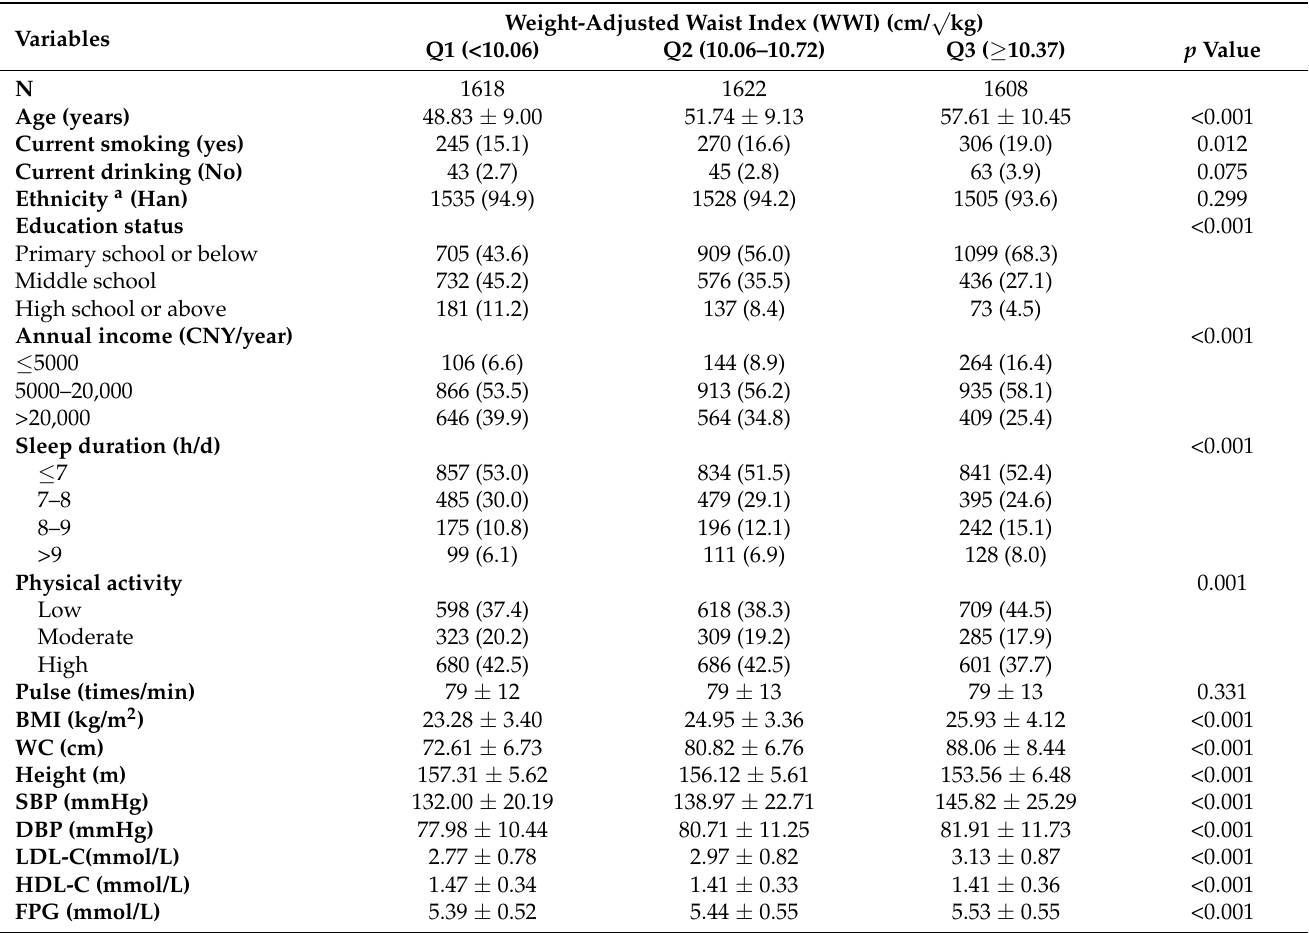
Table 2. Baseline characteristics of study participants by weight-adjusted waist index in